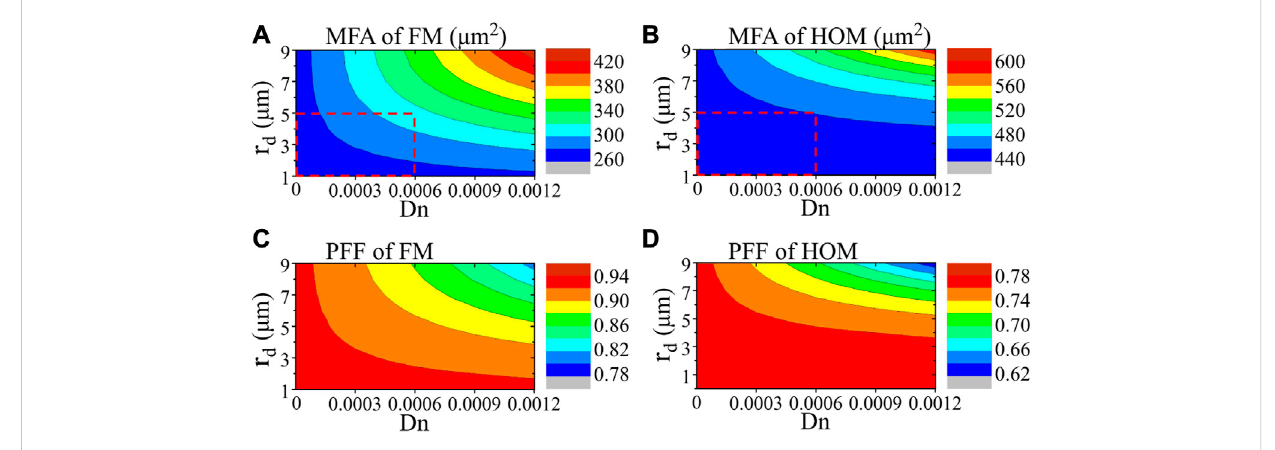
FIGURE 3 The MFA of (A) FM and (B) HOM under different dip depths and radii; and the PFF of (C) FM and (D) HOM under different dip depths and radii.